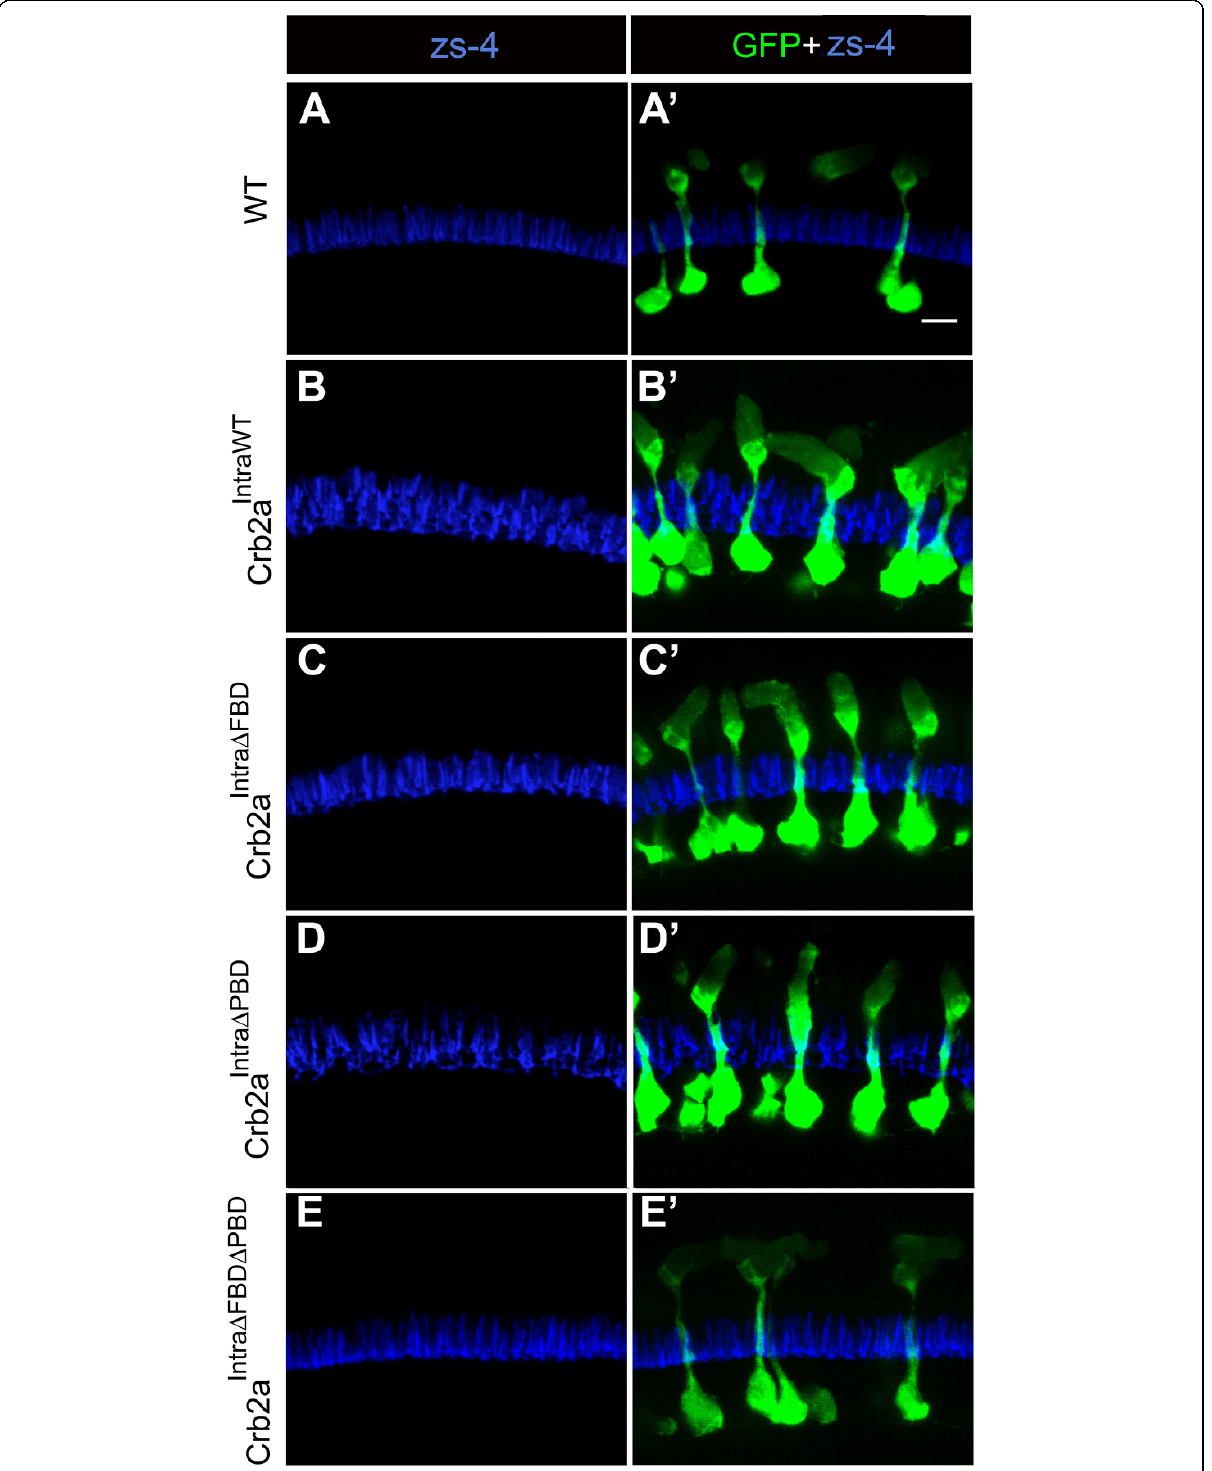
Figure 7 Effects of Crb2a constructs that lack the extracellular domain on endogenous Crb2a . (A-E ’ ) Confocal z-projections of 6 d rods labeled with zs-4 (blue) and anti-GFP (green) antibodies. (A, A ’ ) Wild-type rods. (B, B ’ ) Crb2a IntraWT transgenic rods. (C, C ’ ) Crb2a Intra Δ FBD transgenic rods. (D, D ’ ) Crb2a Intra Δ PBD transgenic rods. (E, E ’ ) Crb2a Intra Δ FBD Δ PBD transgenic rods. Scale bar, 5 μ